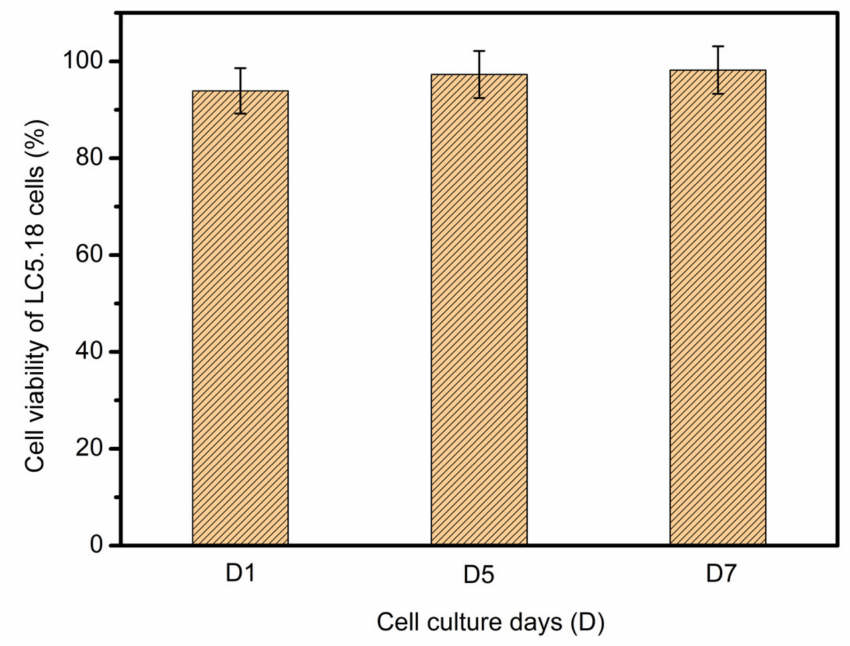
Figure 20. Cellular viability of LC5.18 cells on sca ff old surface after one-day, five-day and seven-day